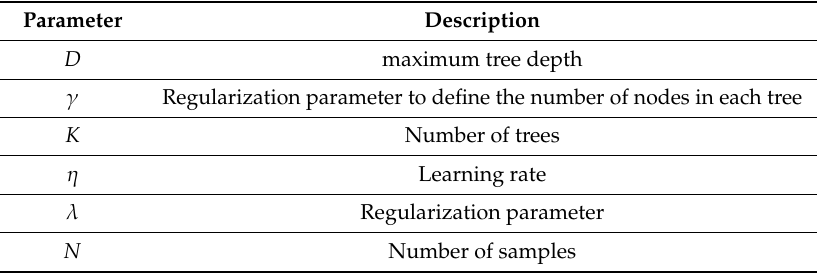
Table 2. XGBoost hyperparameters.